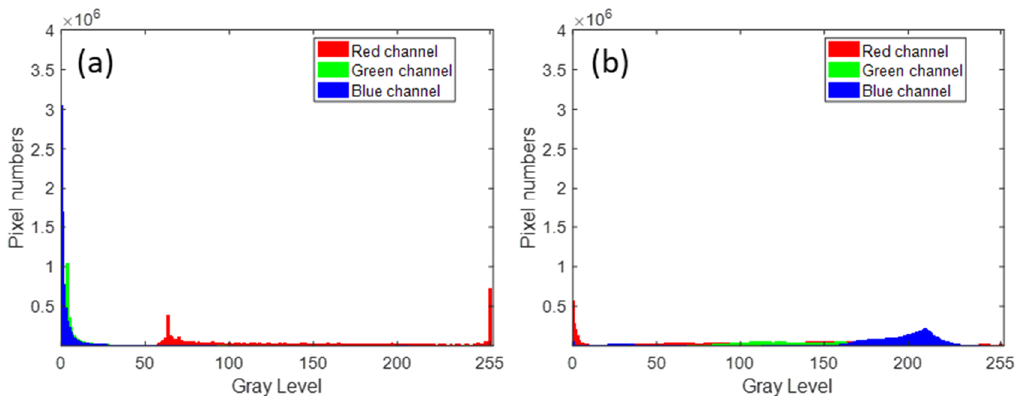
the power saving is only ~7%. Crystals 2020 , 10 , x FOR PEER REVIEW